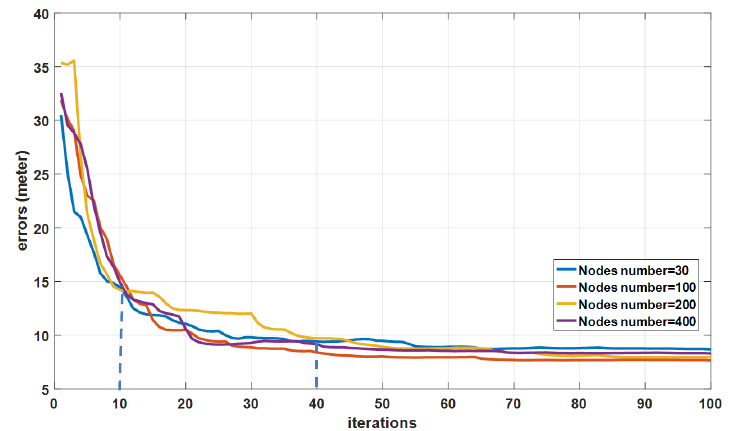
Figure 5. Convergence